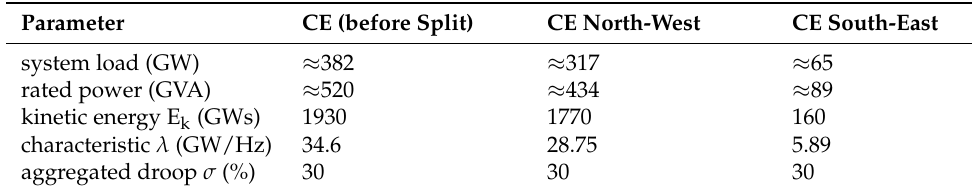
Table 4. System simulation